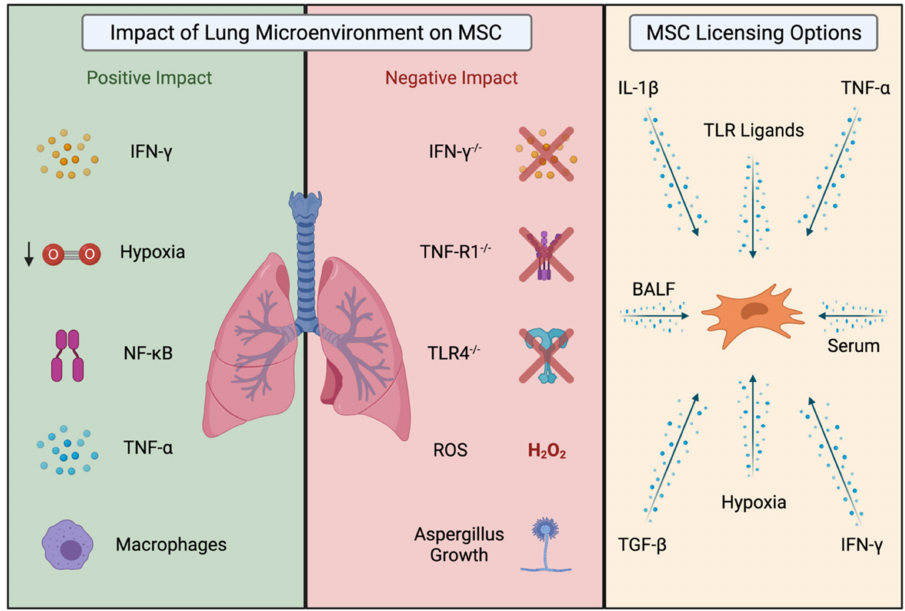
Figure 1. The Lung Microenvironment can positively or negatively influence MSC licensing and therapeutic effects. The presence of pro-inflammatory cytokines IFN- γ and TNF- α license MSCs